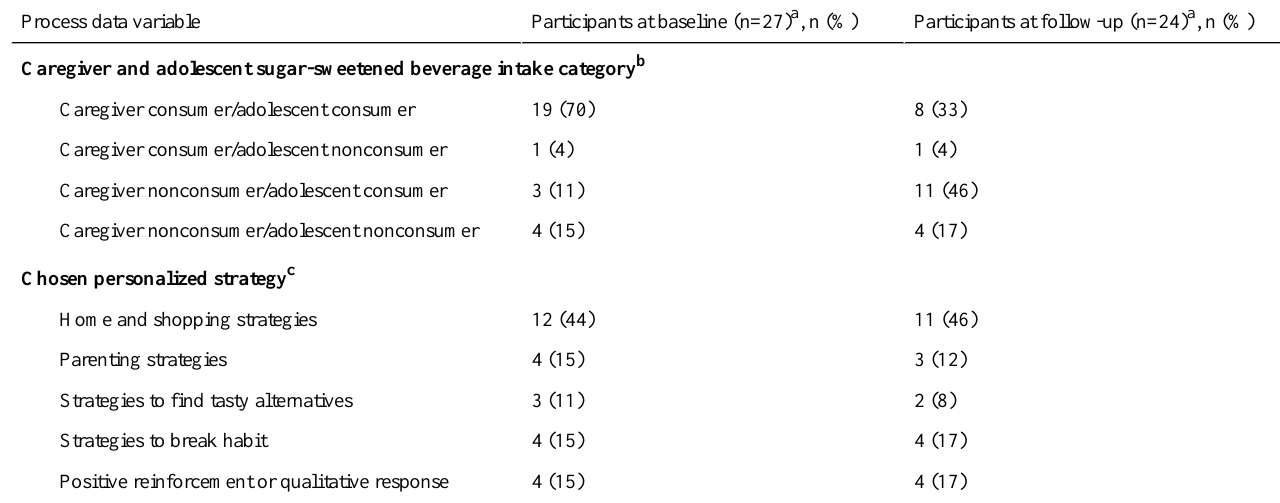
Table 2. Text message–based assessment process data: changes in the sugar-sweetened beverage consumption category and changes in personalized strategy